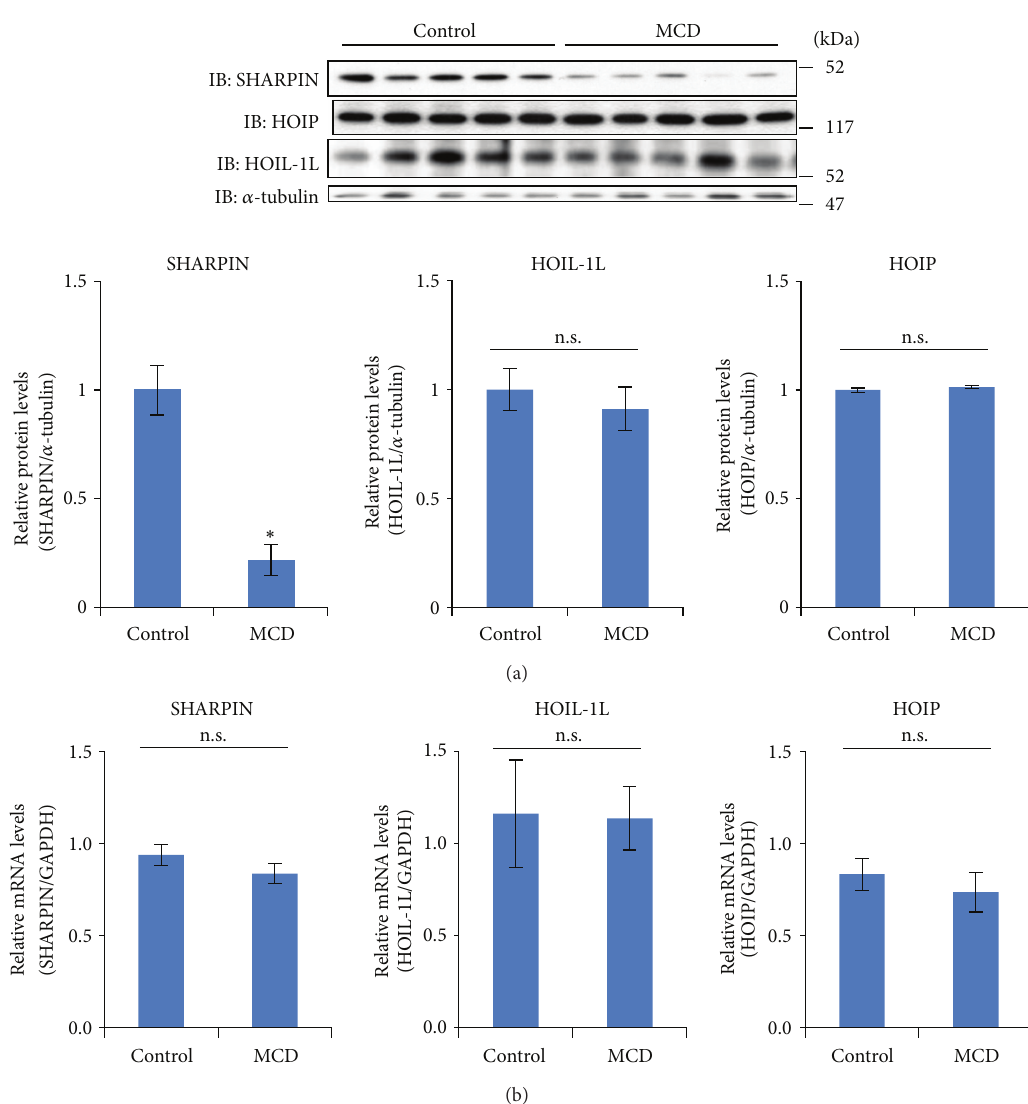
Figure 3: (a) Eight-week-old mice were fed the control or the MCD diet for 8 weeks ( 𝑛 = 5 for each group). Their livers were homogenized in lysis buffer and cell lysates were separated by SDS-PAGE. Expressions of HOIP, HOIL-1L, and SHARPIN were determined by western blot using the corresponding antibodies. Each lane in the immunoblot corresponds to a different mouse. The quantitative SHARPIN/ 𝛼 -tubulin data are shown in the bar graph. Data are shown as means ± S.E.M. ∗ 𝑝 < 0.05 . (b) RNA was isolated from the livers and mRNA levels of SHARPIN, HOIL-1L, and HOIP were determined by real-time PCR using primers corresponding to their mRNA sequences ( 𝑛 = 5 ). The data were normalized with the expression of GAPDH